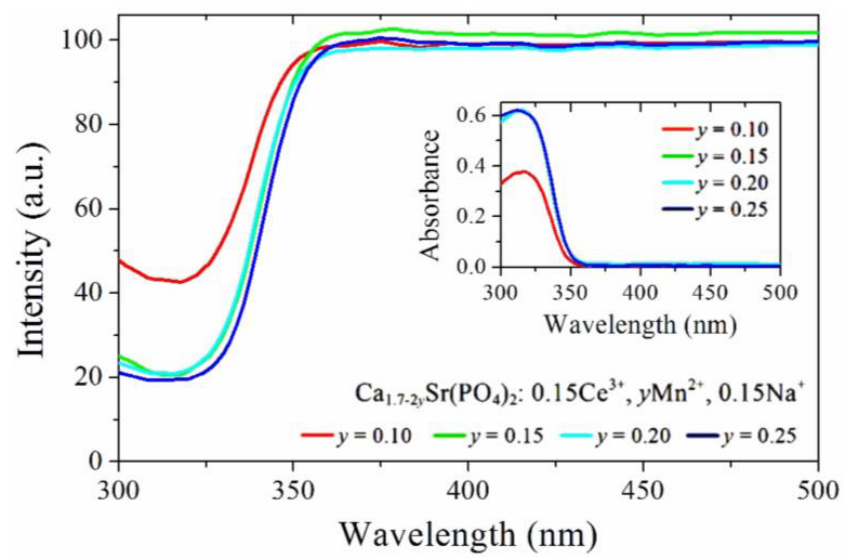
Figure 5. Diffuse reflectance and UV–Vis absorption spectra of Ca 1.7-y Sr(PO 4 ) 2 :0.15Ce 3+ , yMn 2+ , and 0.15Na + . Adapted with permission from ref. [38]. Copyright 2017 Royal Society of Chemistry.